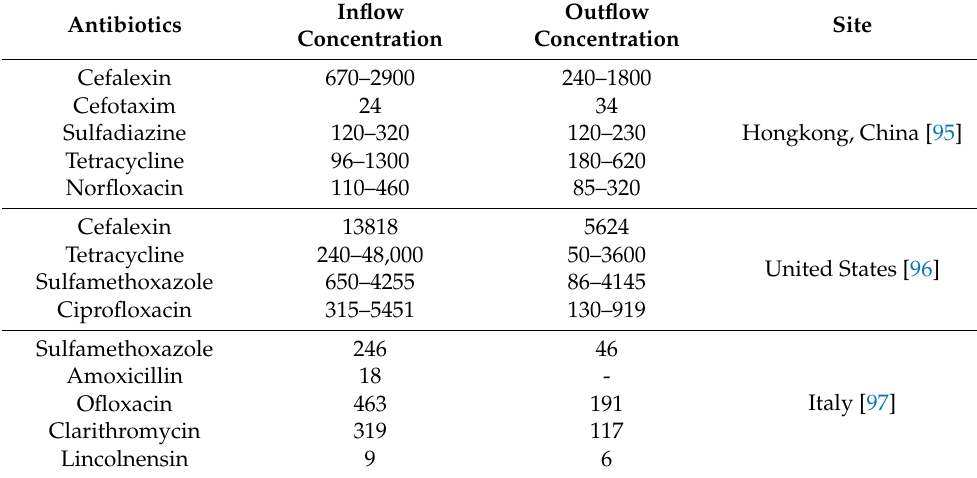
Table 3. The antibiotic concentrations in the inflow and outflow of wastewater treatment plants